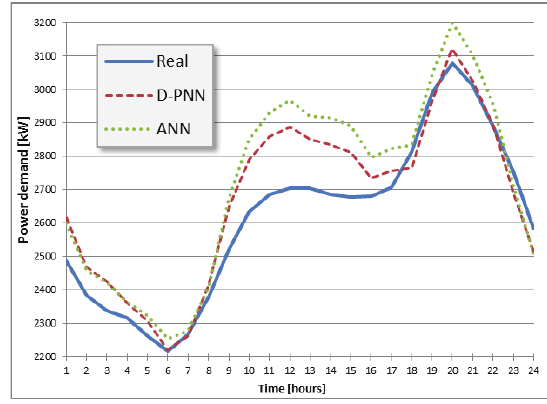
Fig. 7. TEPCO : 13.5.2012 (Sunday). D-PNN RMSE = 96.5 , ANN RMSE = 135.9